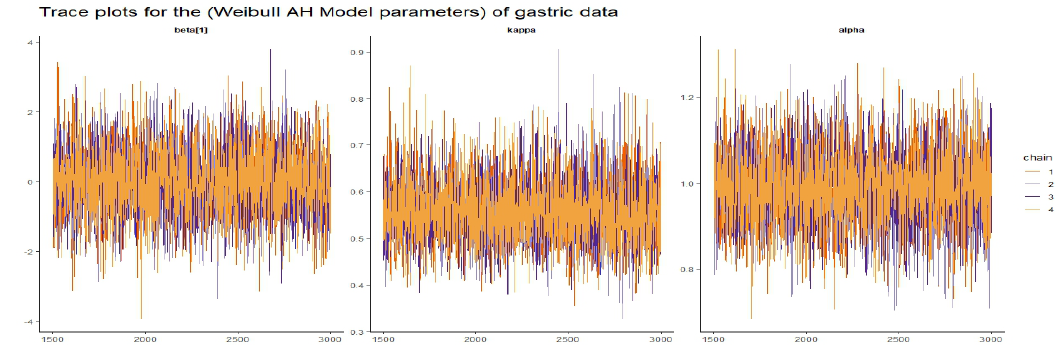
Figure 7. The LL–AH model posterior parameters trace plots of the gastric cancer data.